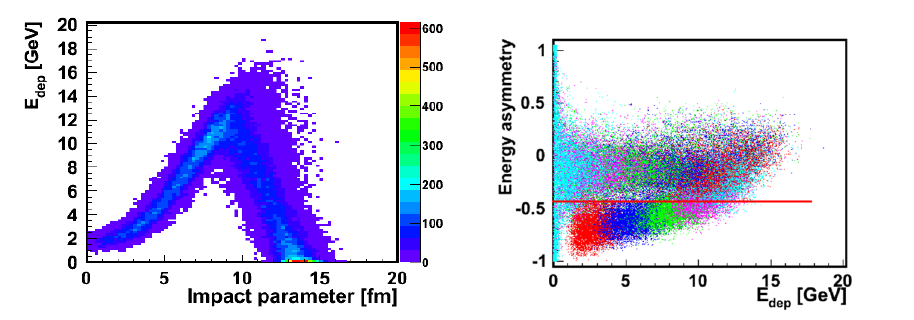
are shown. The observed non-monotonic behavior is due to fragments energy not measured in the beam hole. The FHCal simulations have been done for reaction Au + Au@4.5 AGeV for events generated with by LAQGSM code and use bmnroot framework with FTFP-BERT physics list. The smearing of the beam spot on the target ( σ x = σ y = 3 mm) has been done also.